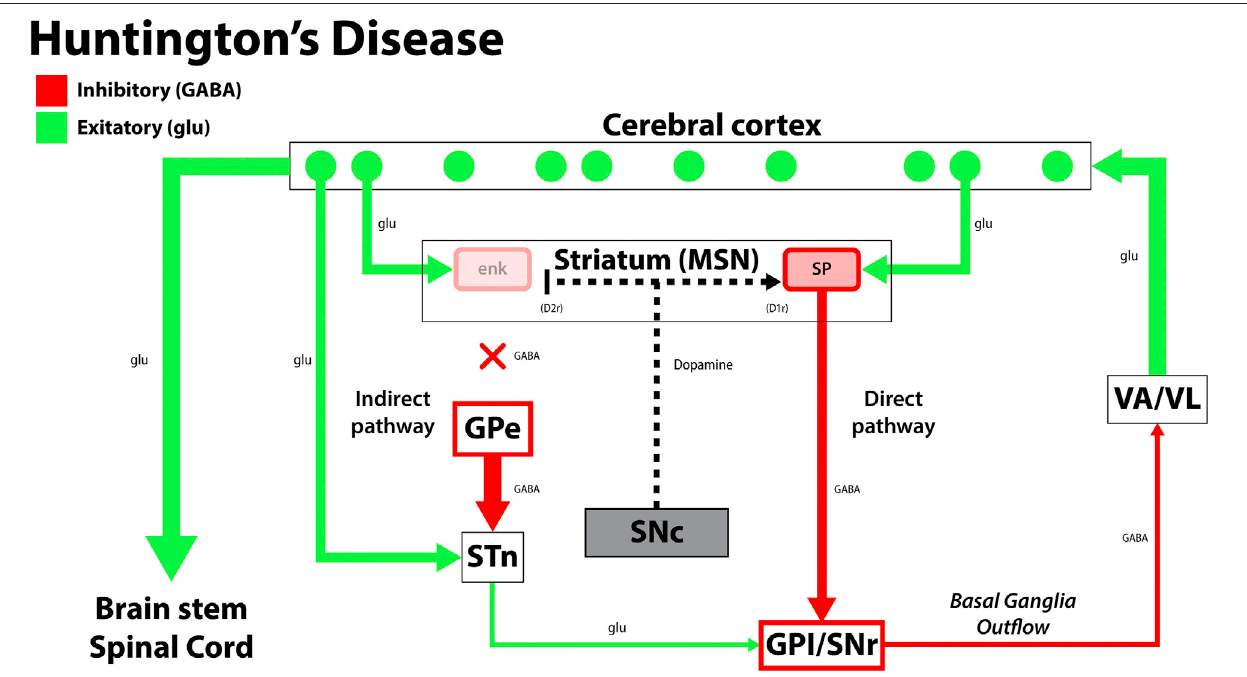
FIGURE2| ThedisruptioninthefunctionalcircuitinHuntington ’ sdisease.Cerebralcortexatrophyandlossoftheindirectpathwayleadstomoremotoroutputand resultsinthechoreiformmovementsseeninHD.GreenarrowssignifyglutamatergicexcitatoryneuronsandredarrowssignifyGABAexpressinginhibitoryneurons.enk, enkephalin; SP, Substance P; GPe, globus pallidus, external segment; GPi, globus pallidus, internal segment; SNc, substantia nigra pars compacta; SNr, substantia nigra pars reticulata; STN, subthalamic nucleus; VA/VL, ventral anterior/ventral lateral nucleus of the thalamus; D1r, D1 dopaminergic Gs coupled receptor; D2r dopaminergic Gi coupled receptor. Adapted from (Essa et al.,